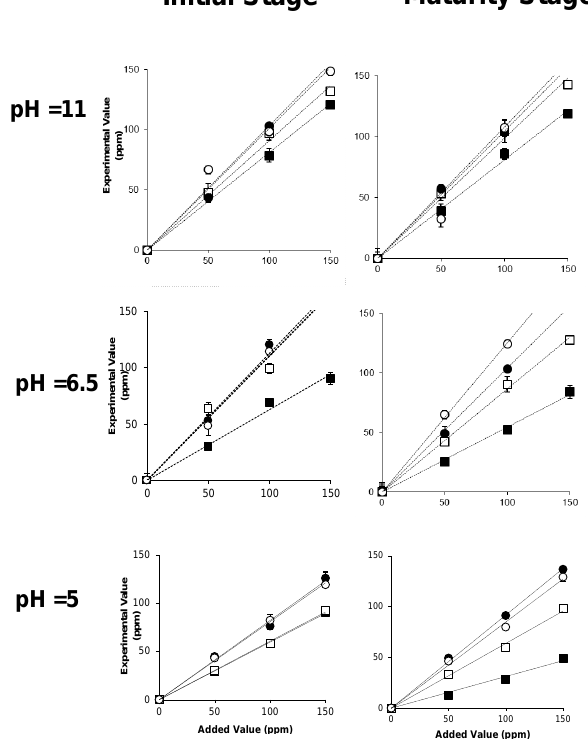
Fig.3. Retention of PNP with different pH solution in the compost samples of cow Figure 3. Retention of PNP with different pH solution in the com- manure CM ( □ ), cow manure + biochar CM+B ( ■ ), cow manure control CM-C( ○ ), post samples of cow manure CM ( (cid:3) ), cow manure + biochar and cow manure + biochar control CMB-C ( ● ) during the composting process. CM+B ( (cid:4) ), cow manure control CM-C ( ◦ ), and cow manure